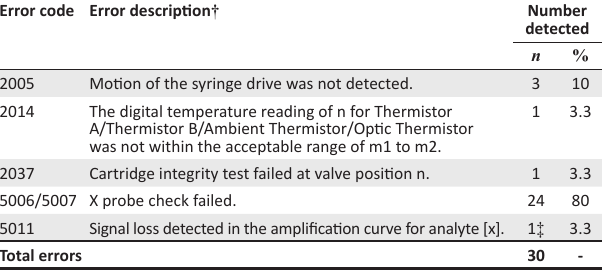
TABLE 2: Errors received during validation of dried tube specimens for 2013– 2015 proficiency testing panels, 2013–2015, United States Centers for Disease Control and Prevention (Atlanta, Georgia, United